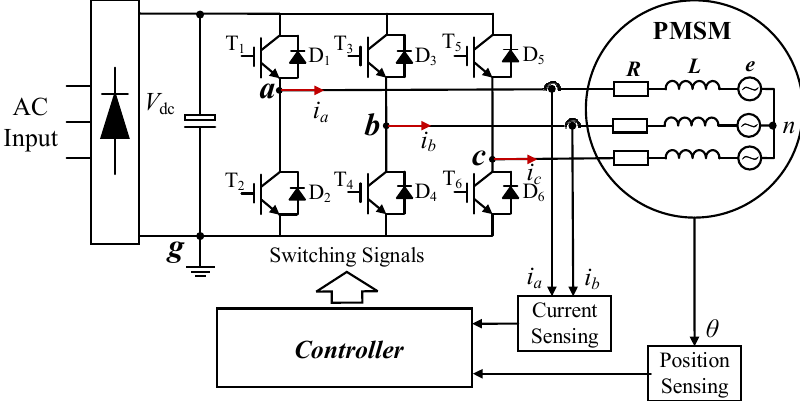
Figure 1. Typical structure diagram of the PMSM (permanent magnet synchronous motor) drive